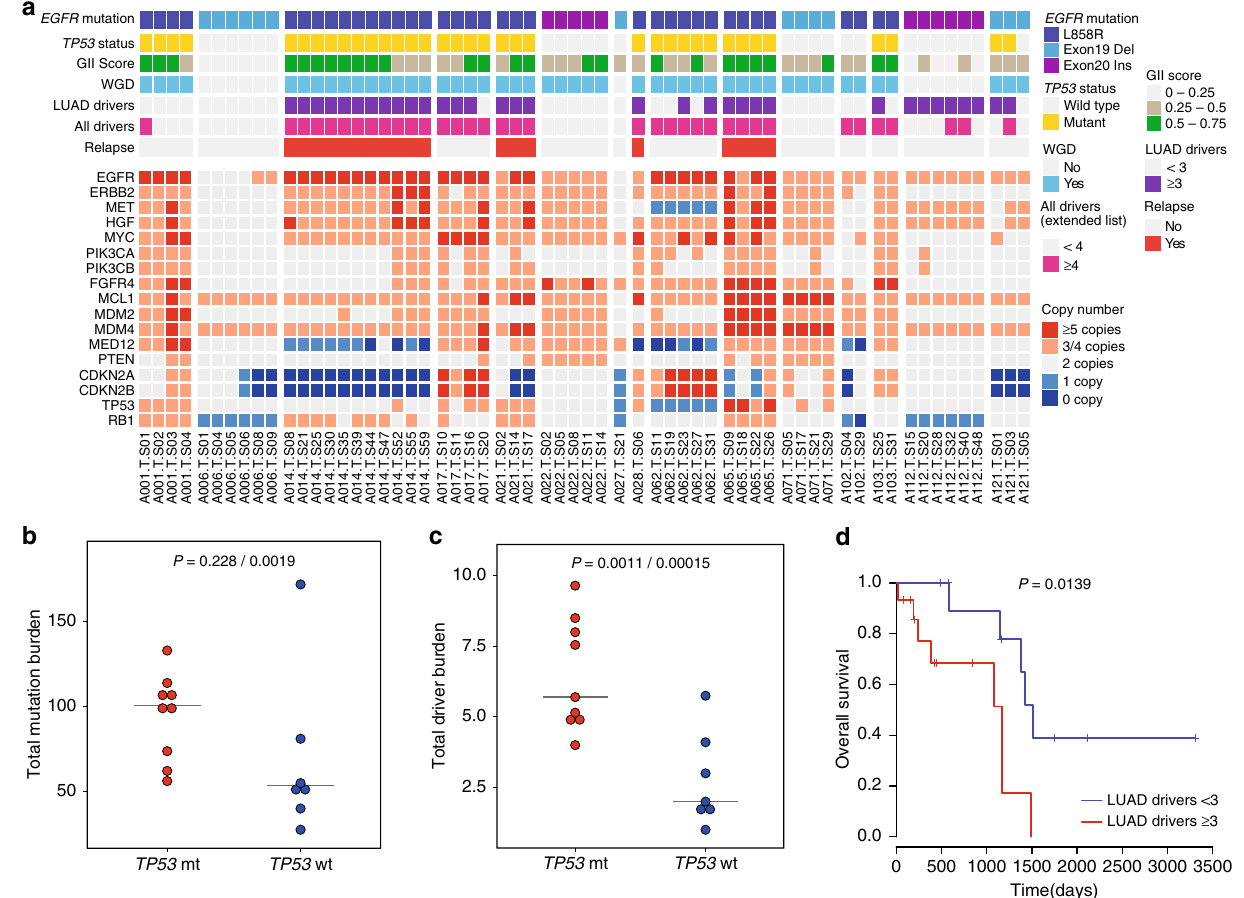
Fig. 4 TP53 mutations, genomic instability, high-driver burden lead to poor outcome. a Lower panel is a heatmap representing number of copies for selected genes involved in EGFR TKI resistance or associated with prognosis. Upper panel represents features of a tumor which are associated with patient outcome like TP53 mutation status, genomic instability index, presence of whole-genome doubling, above and below median number of drivers (LUAD speci fi c or extended driver list) and the relapse status. All these features tend to coincide in many tumors. b Total mutation burdens and c driver burdens (extended driver list) are compared between TP53 mutant (mt) and wild-type (wt) tumors. Three random sectors were picked iteratively ( n = 20) and averages across iterations are represented in b and c . The fi rst p -value is taking all 16 patients into consideration and the second p -value is after eliminating the outlier A102 in the analysis. P -values are calculated using Welch ’ s t -test. d Survival plots using TCGA LUAD EGFR -mutant cases (those with non-silent mutations in tyrosine kinase domain, n = 26) 4 after stratifying above or below median number of LUAD drivers (median = 3). P -value from χ 2 -test is homozygous deletions in two tumors (Fig. 2d; Supplementary Fig. 13a; Supplementary Data 4, 5). Interestingly, all TP53 wild- type tumors had truncal losses affecting the 13q14.2 region containing RB1 (Fig. 2d) and four of these tumors had loss of heterozygosity (LOH) containing just single copy of this gene (Supplementary Fig. 13b). In addition to recurrent somatic mutations in TP53 , we further observed recurrent truncal LOH in 7/11 tumors including those without any mutations (Supple- mentary Fig. 13c). In EGFR -mutant tumors with TP53 mutations, 6/9 tumors were found to have LOH and loss in copy number in RB1 region (3 tumors with potentially truncal LOH; Supple- mentary Fig. 13b). Overall these fi ndings implicate disruption of the RB1/CDKN2A/TP53 control axis of the cell cycle G1/S and apoptosis checkpoints as an early tumor initiating event in EGFR - mutant LUADs.